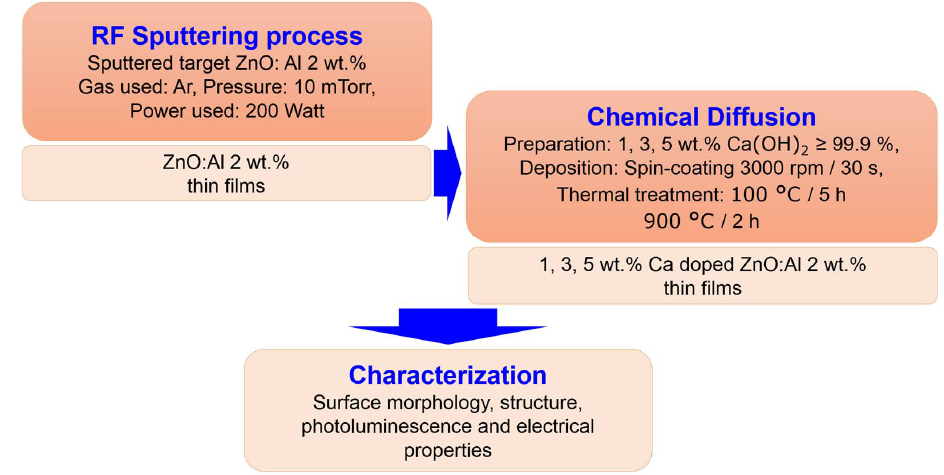
Figure 1. Flowchart of Ca-doped ZnO:Al 2% thin film preparation.